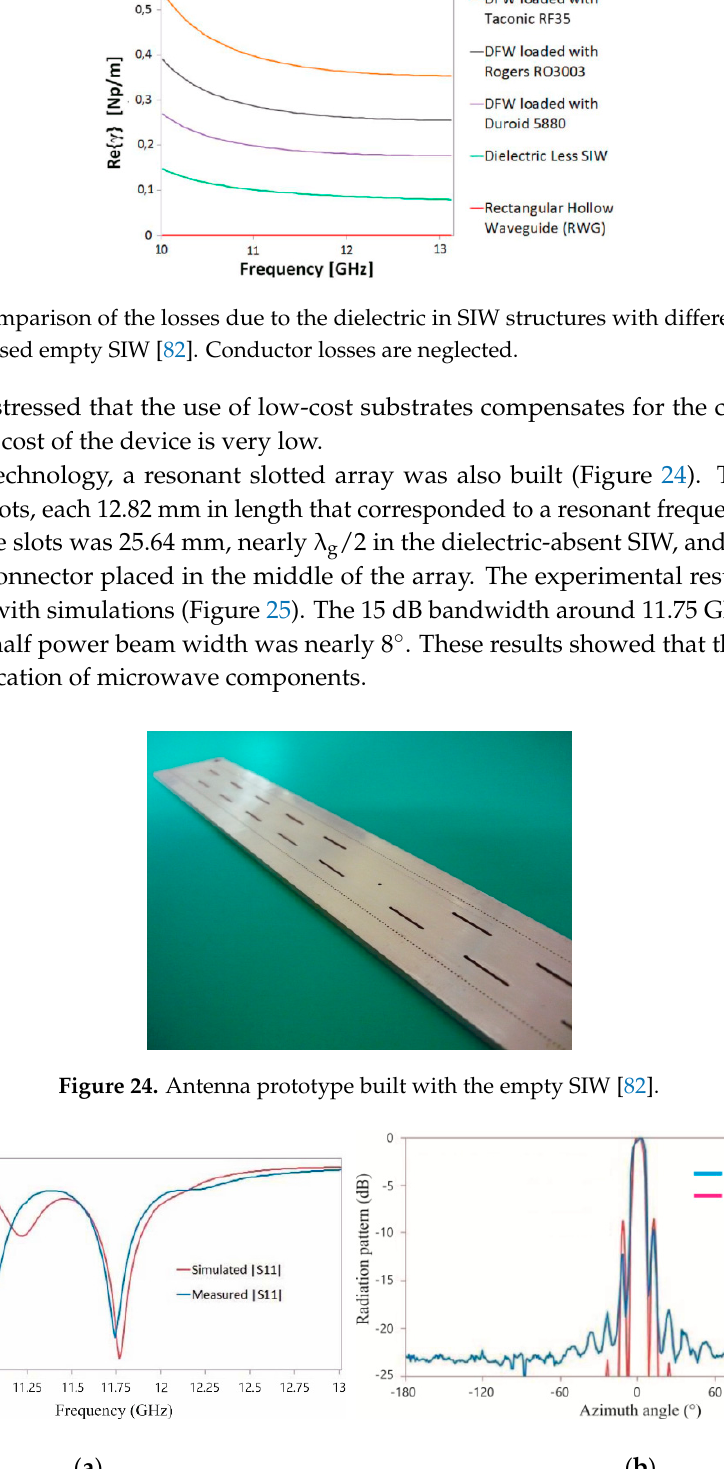
Figure 25. Comparison between simulated and experimental results for the dielectric-absent antenna [82]. ( a ) reflection coefficient; ( b ) radiation pattern.